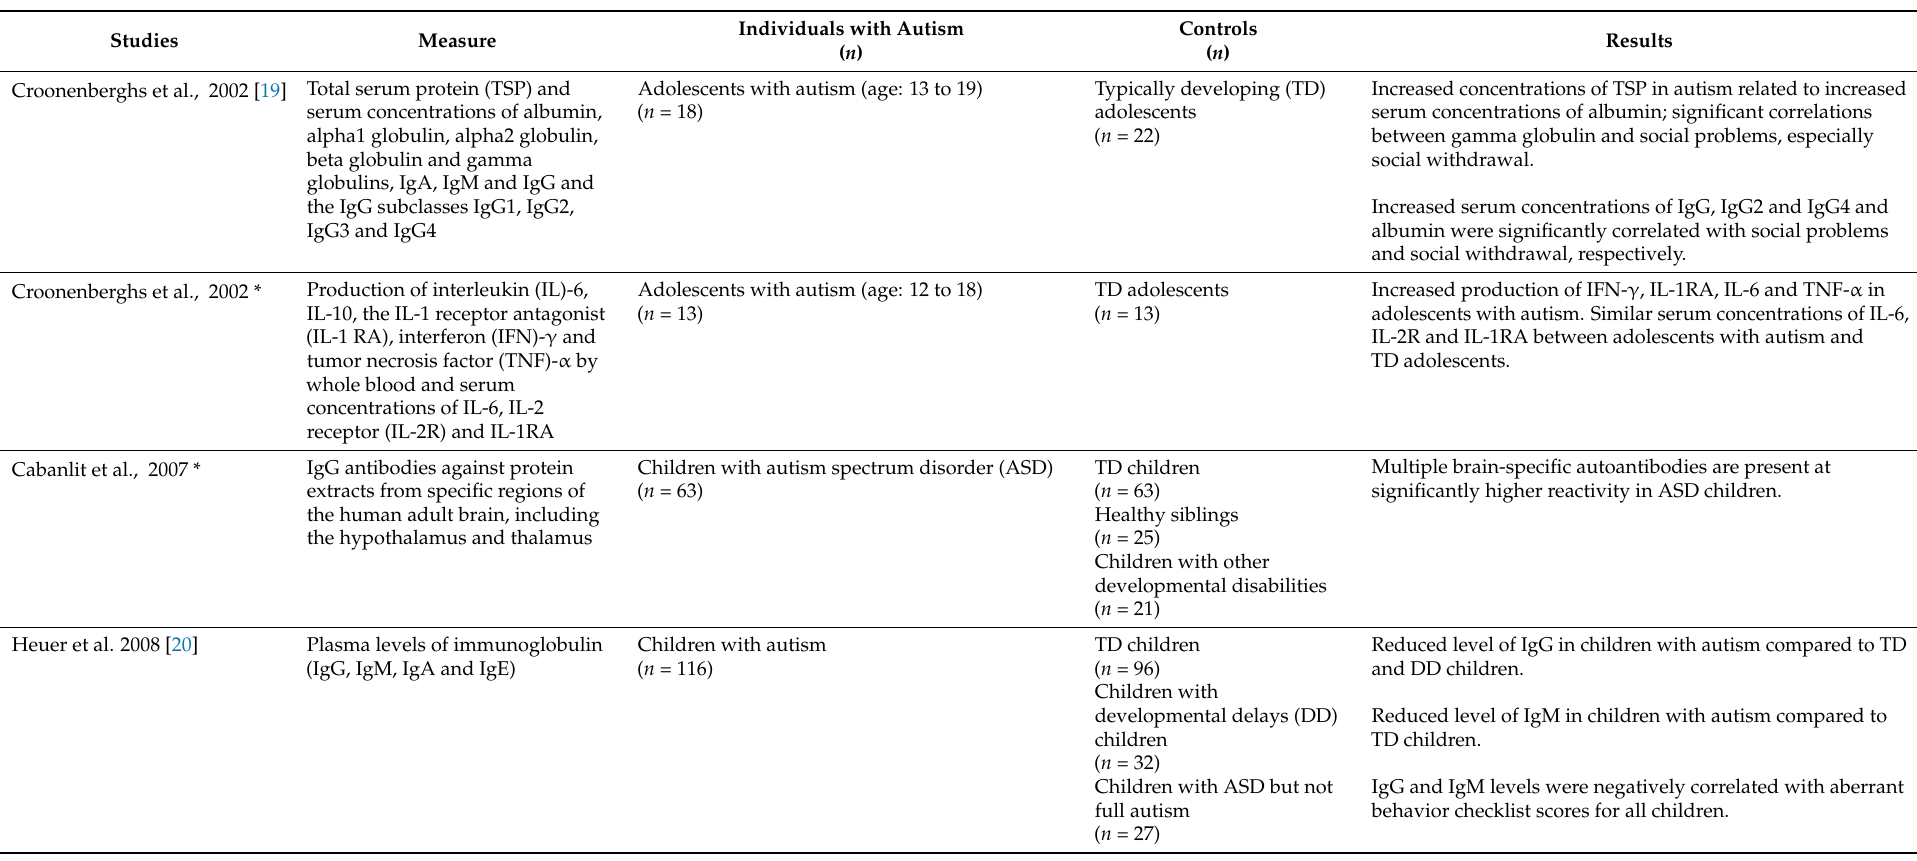
Table 3. Studies of immune autoantibody abnormalities in